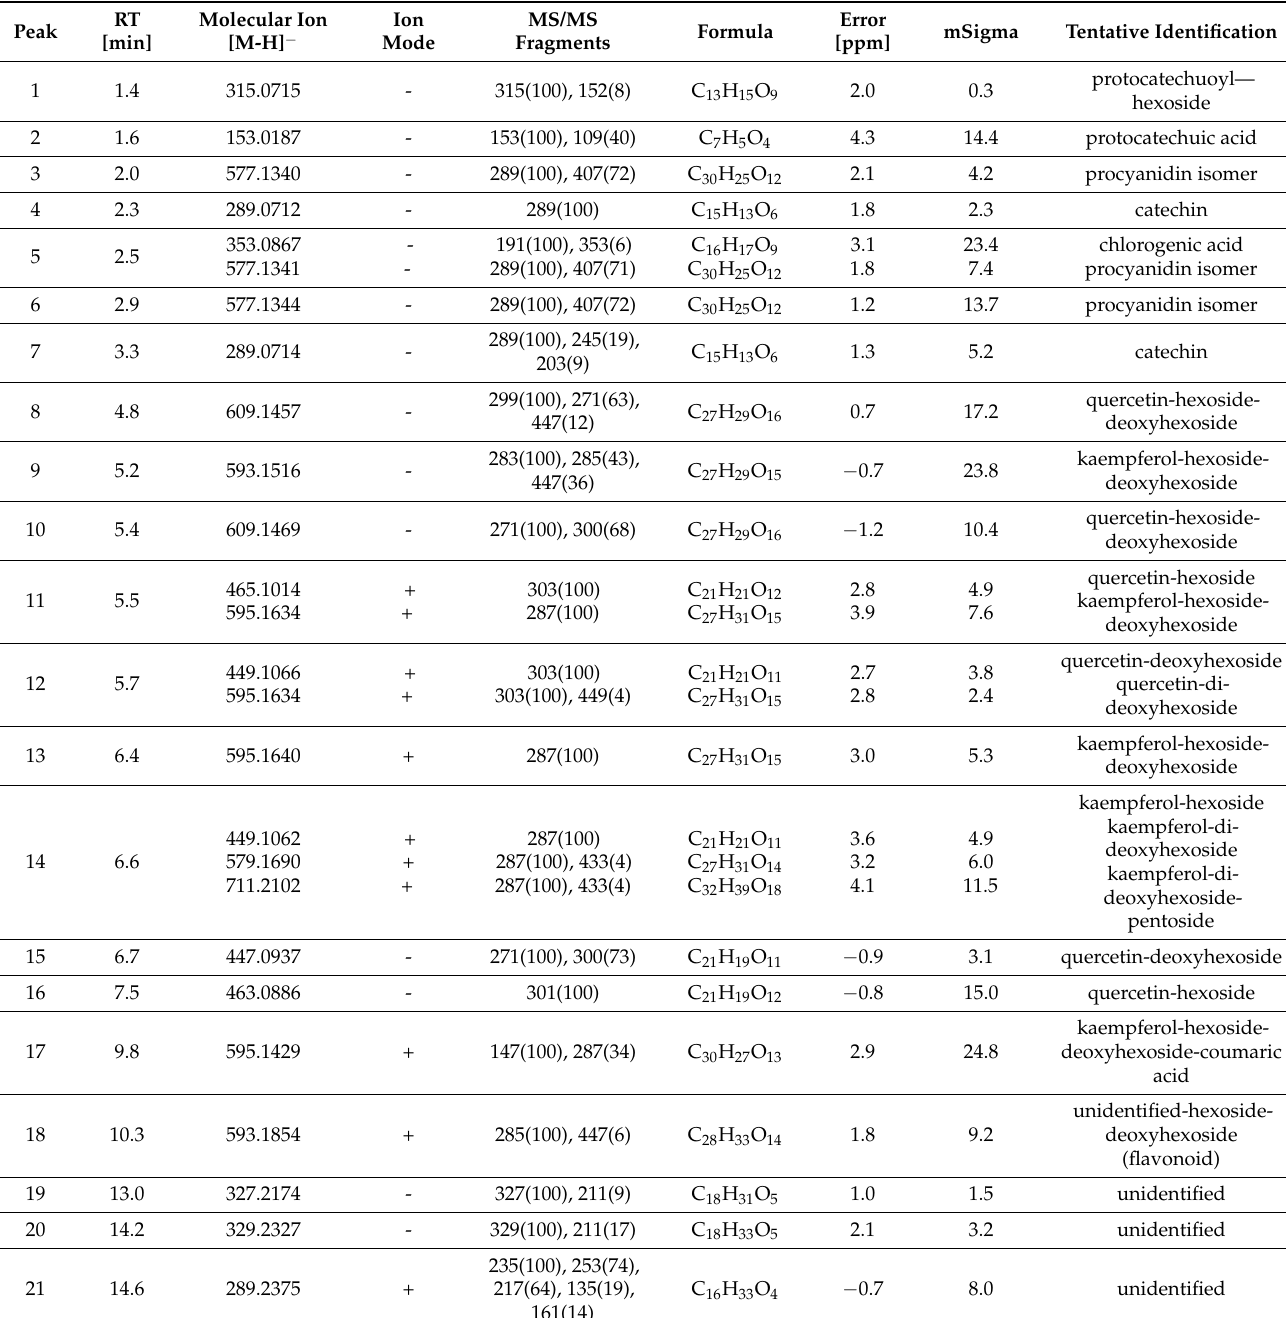
Table 7. Compounds identified in the linden blossom ( Tilia L.) extract using UHPLC-QTOF-MS/MS. Compound numbers correspond to those indicated in Figure